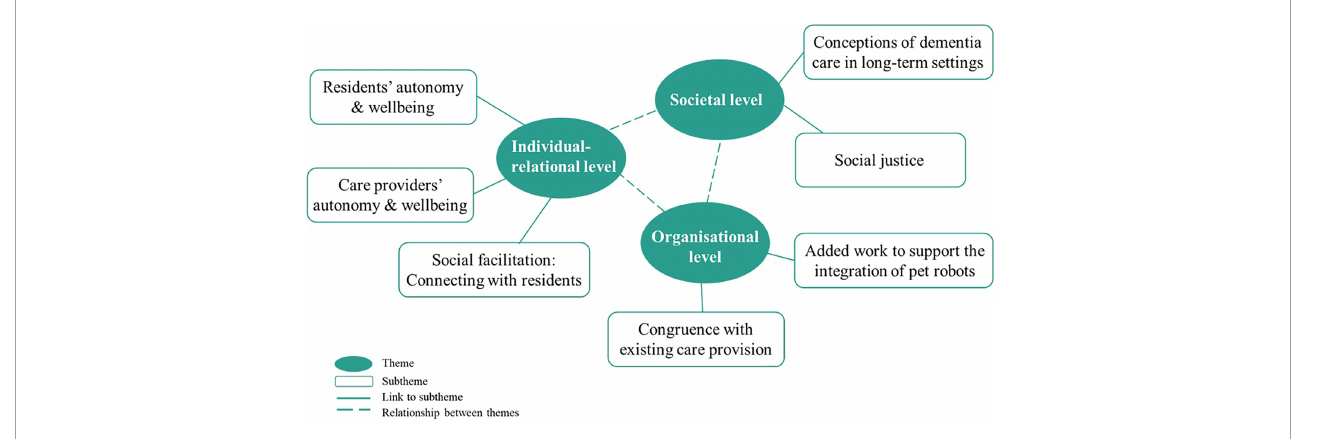
FIGURE1 Thematic map of key themes structured on three